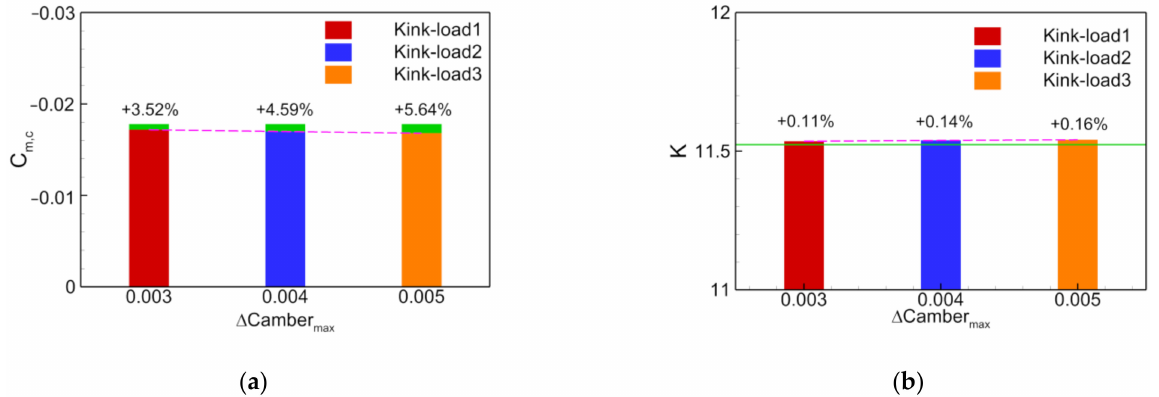
Figure 18. The increments of C m,c and K obtained by fore-loading the kink airfoil at cruise state. ( a ) Pitching moment coefficient; ( b ) Lift-to-drag